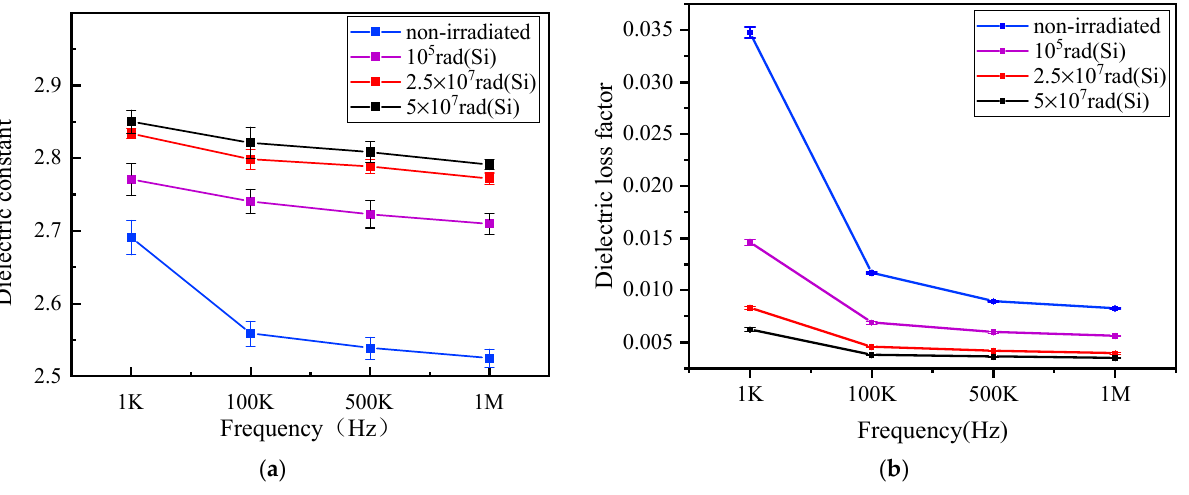
Figure 13. Variation in dielectric constant and dielectric loss factor for samples with different irradiation doses at different frequencies. ( a ) Dielectric constant, ( b ) Dielectric loss factor.